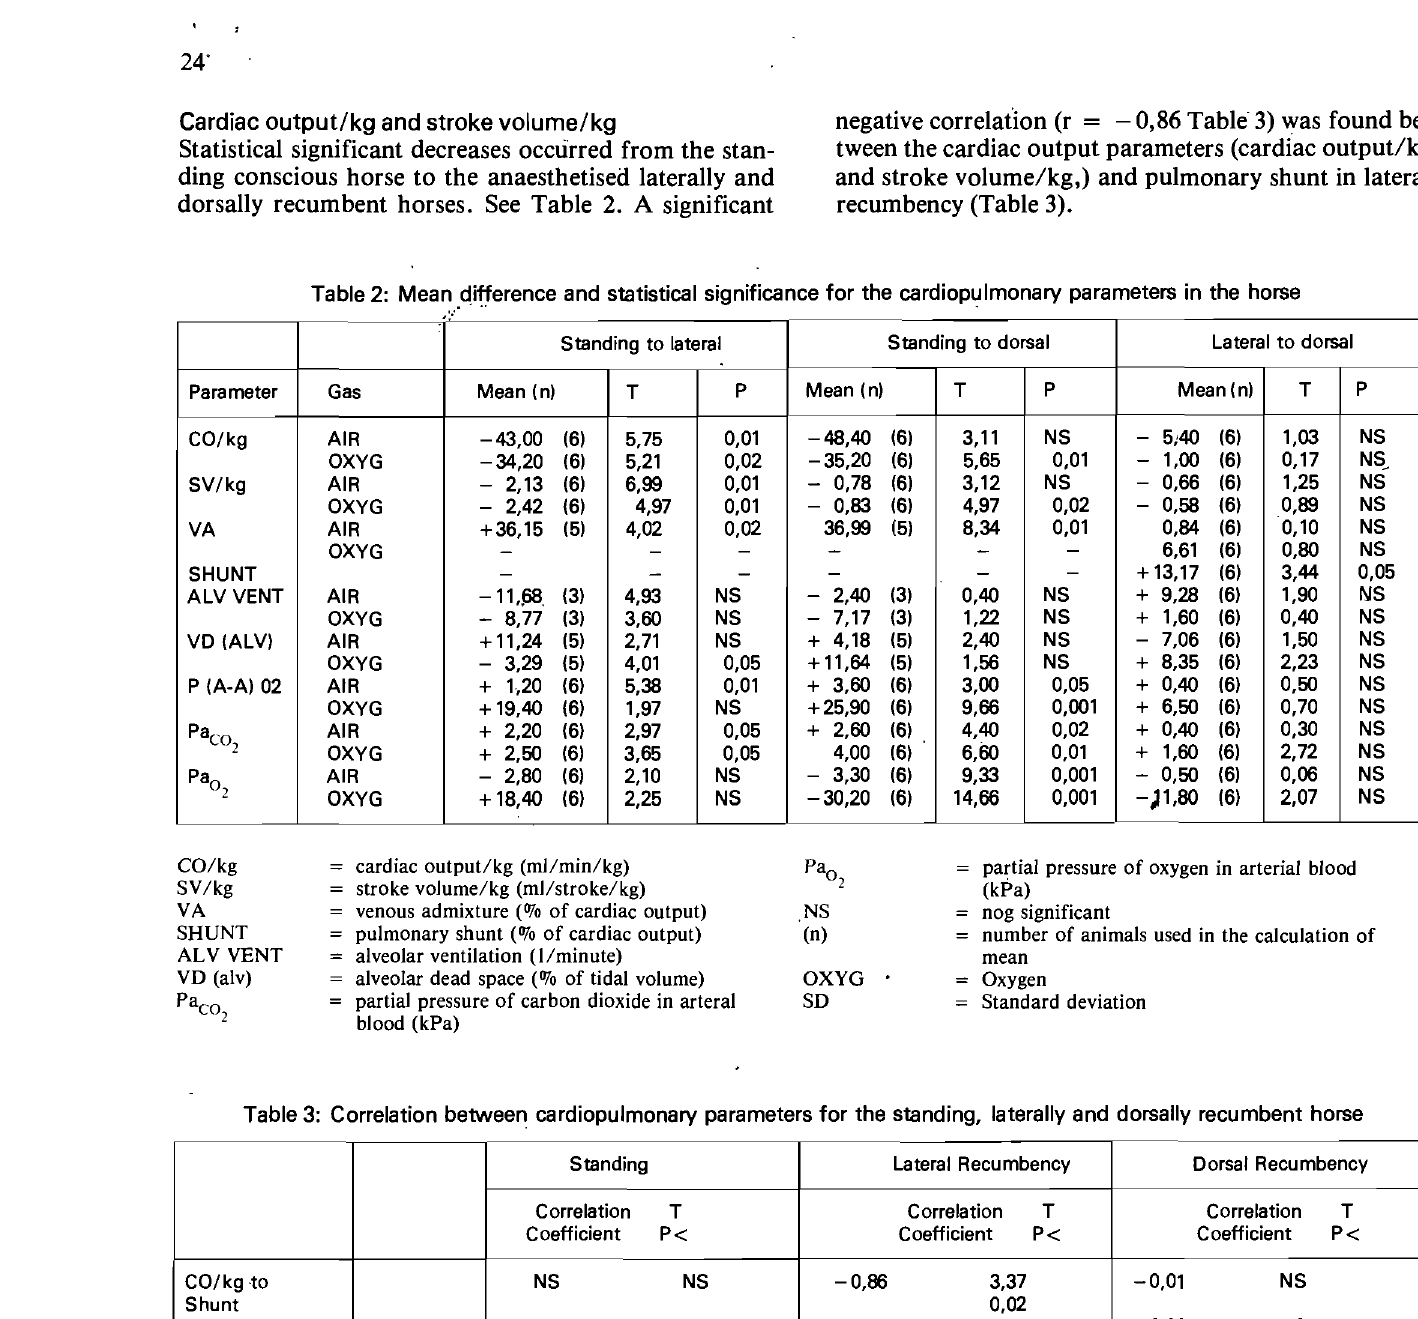
Table 3: Correlation between cardiopulmonary parameters for the standing, laterally and dorsally recumbent